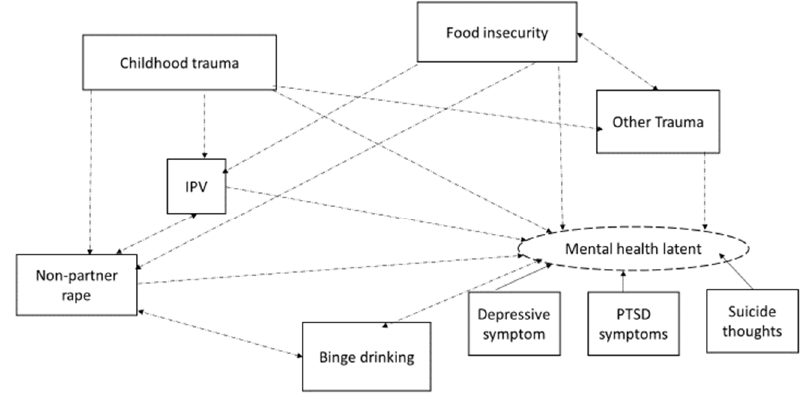
Figure 1. Apriori hypothesised model.